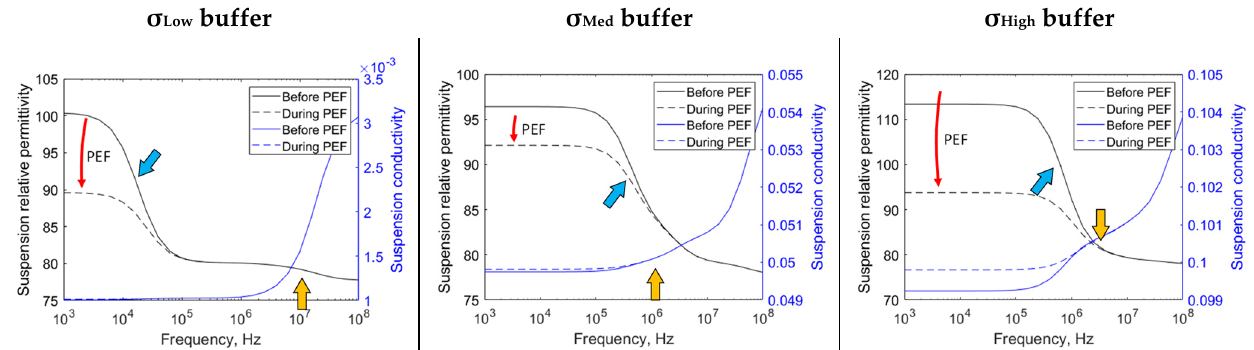
Figure 3. Cell suspension dielectric properties before and during PEF. The electroporation decreases the equivalent solution permittivity. The red arrow indicates the time direction. The blue arrow indicates the membrane main- β -dispersion. The gold arrow indicates the yeast wall peak sub- β -dispersion.